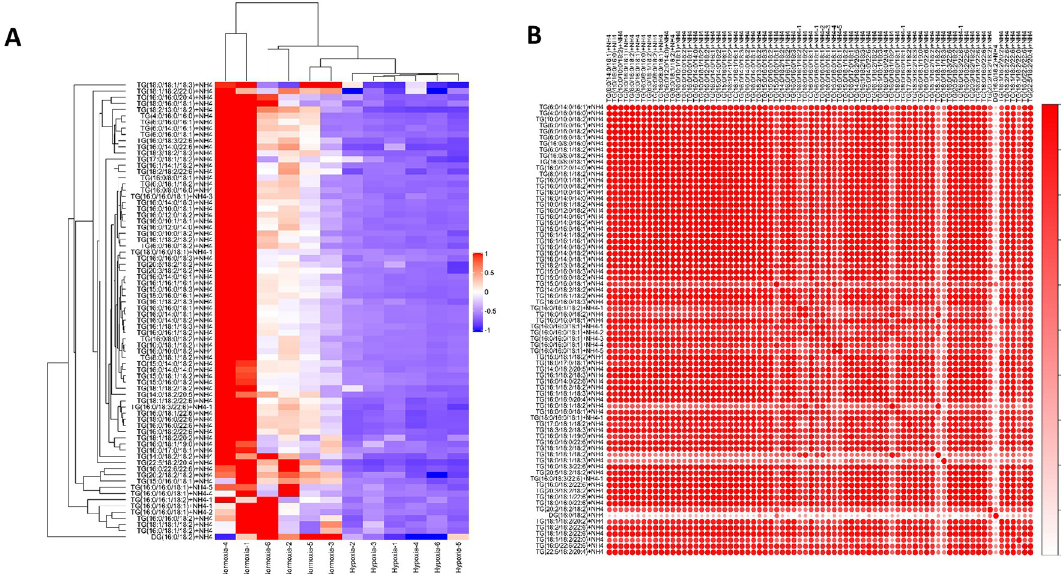
Fig 6. Clustering and correlation analyses of lipids in rat visceral adipose tissue. Correlation clustering heat map. Red represents positive correlation and purple represents negative correlation. Color intensity is related to the absolute value of the correlation coefficient; i.e., the higher the positive or negative correlation, the darker the color. (B) Hierarchical clustering heat